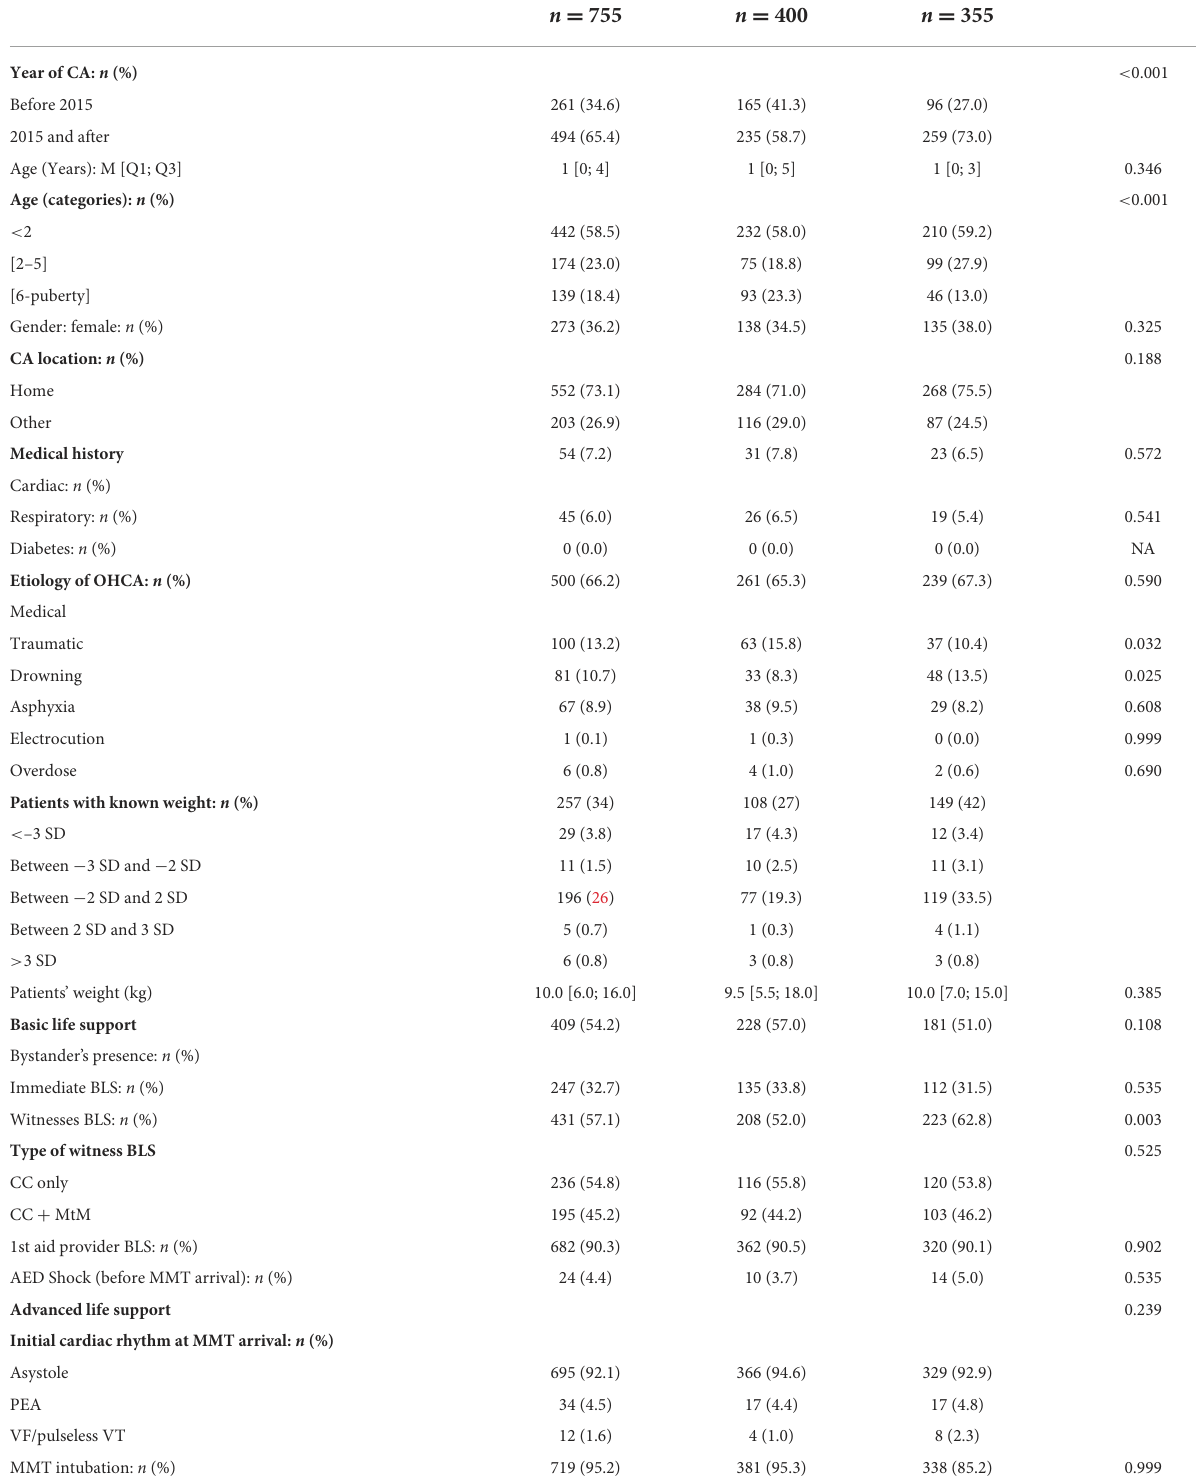
TABLE 1 Characteristics of the study population before